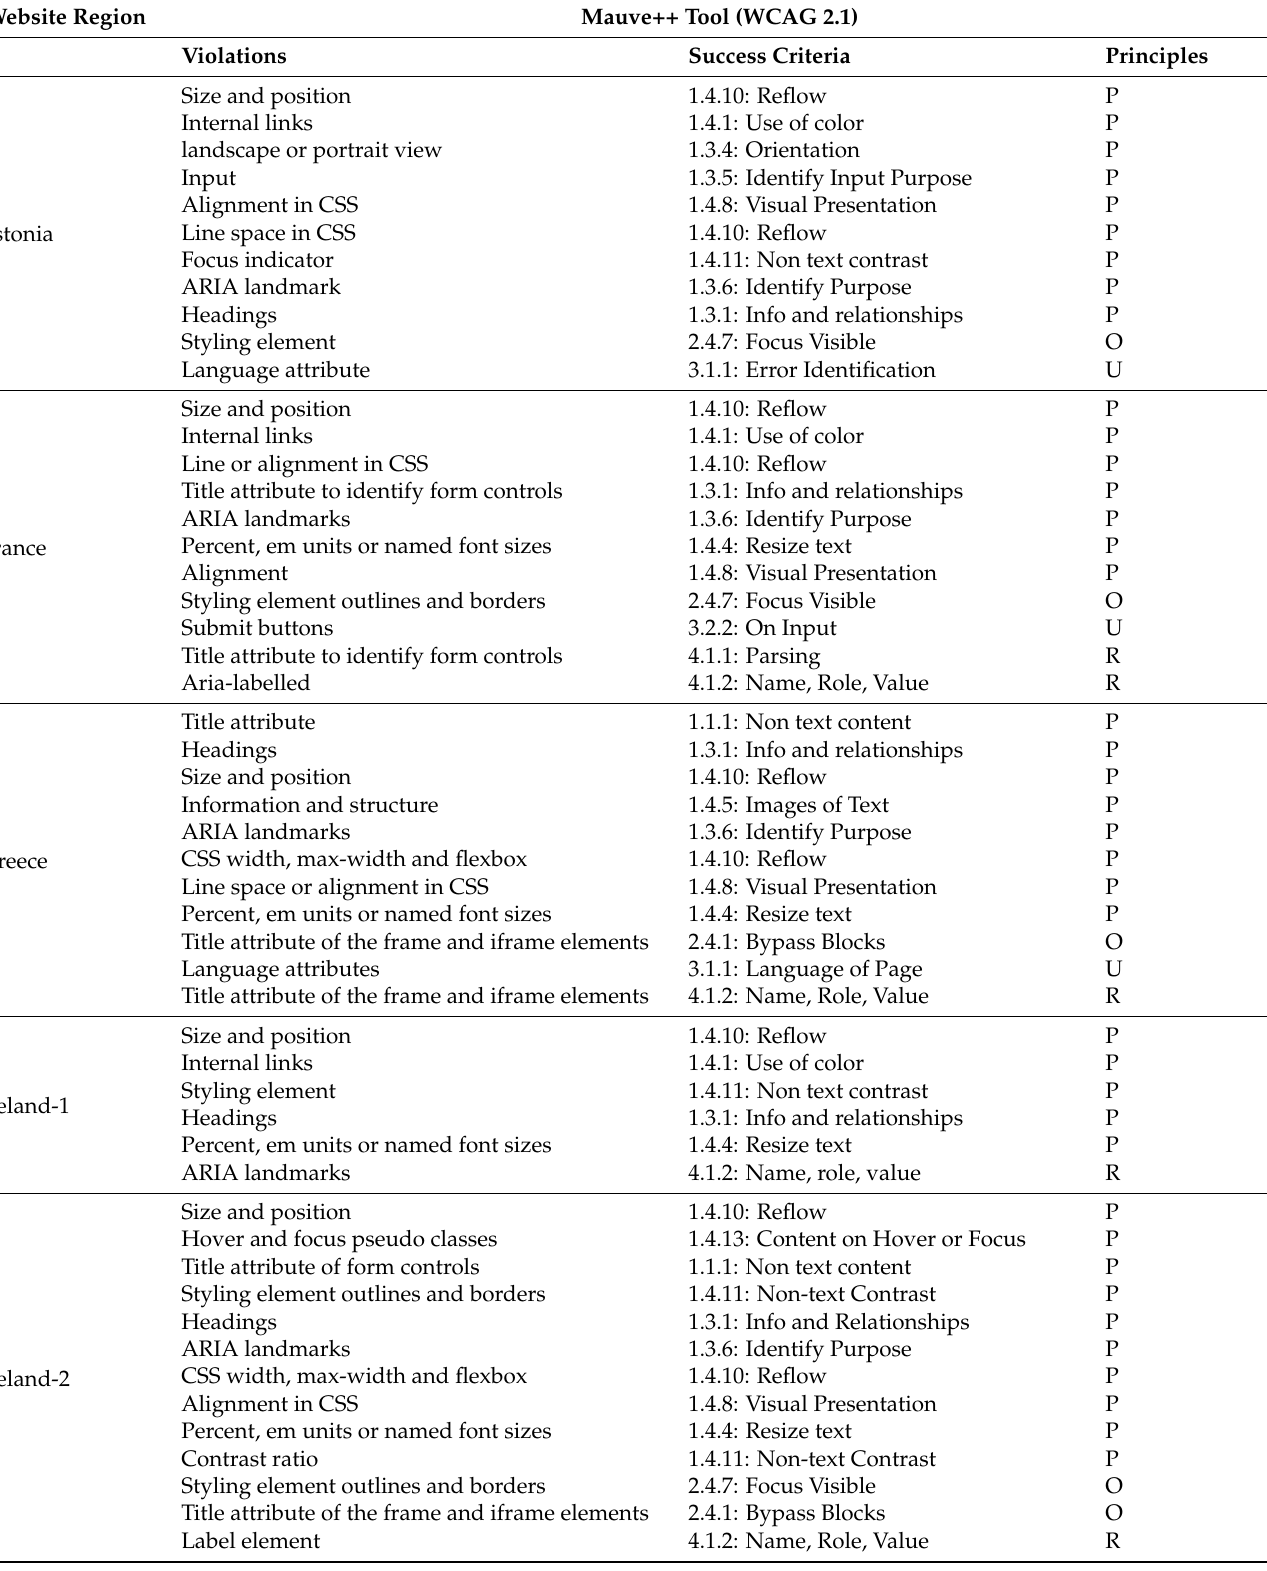
Table A2. Accessibility issues in the website of each country for WCAG 2.1. Website